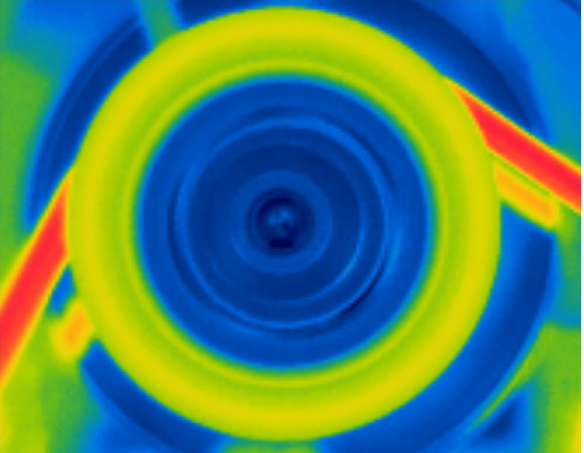
Figure 11. Tangentially homogeneous and radially symmetric temperature distribution of a high-speed FRP